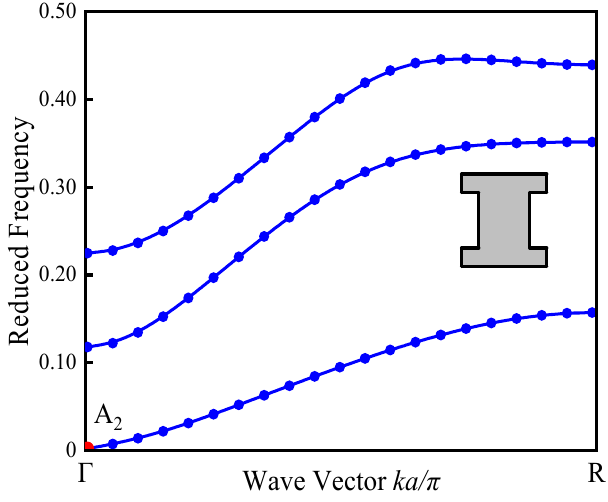
Figure 4. The unconstrained REM dispersion relation curve.